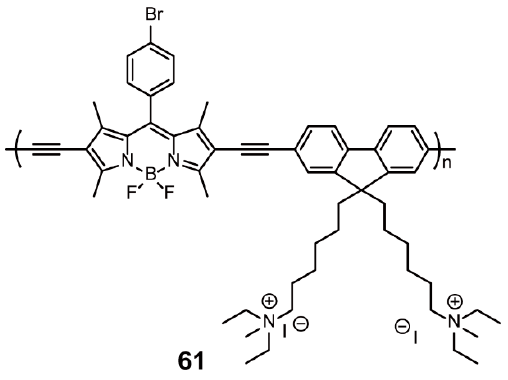
Figure 19. Chemical structure of polymer 61 (Reproduced with permission from Reference